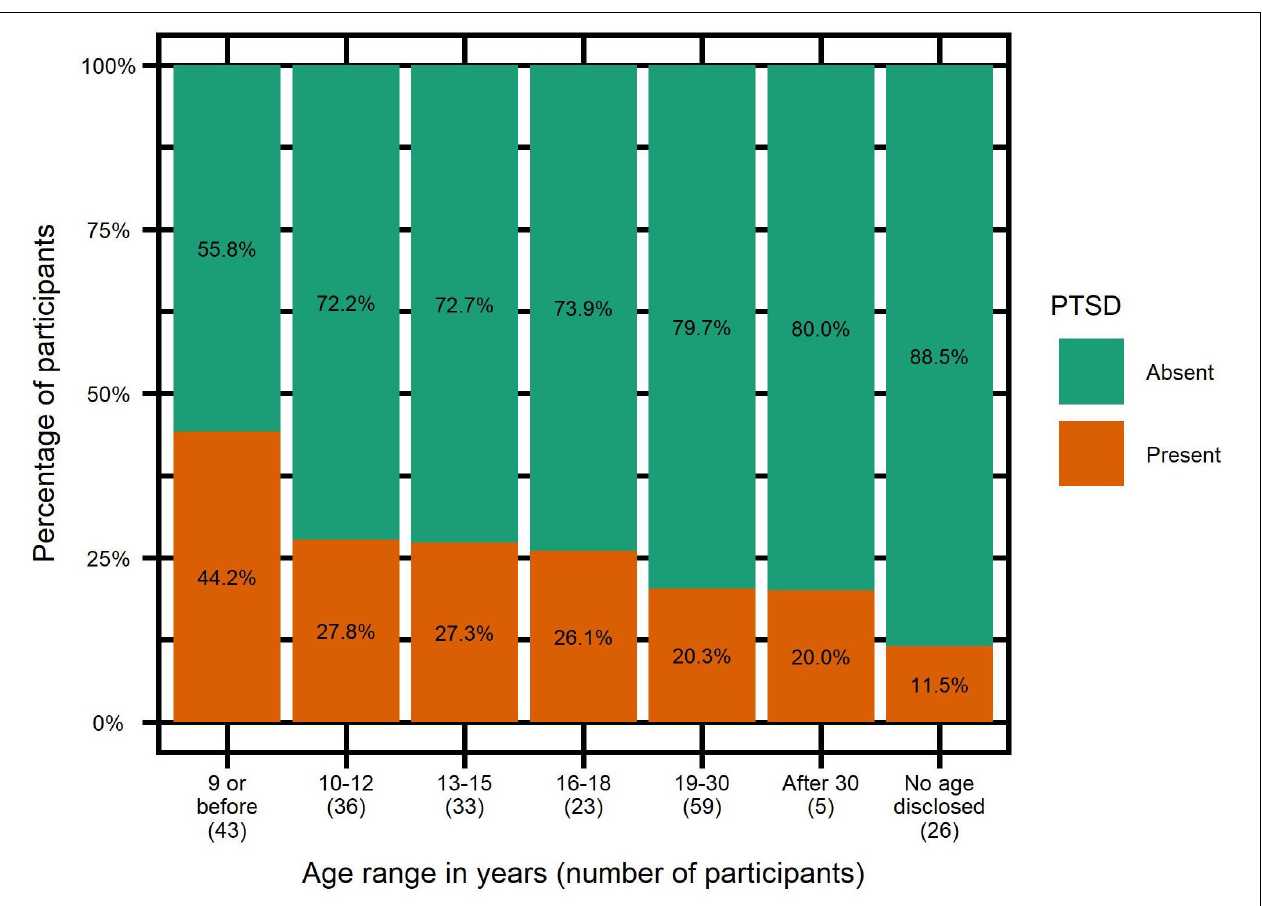
FIGURE 7 | Post-traumatic stress disorder rates depending on age at first assault.